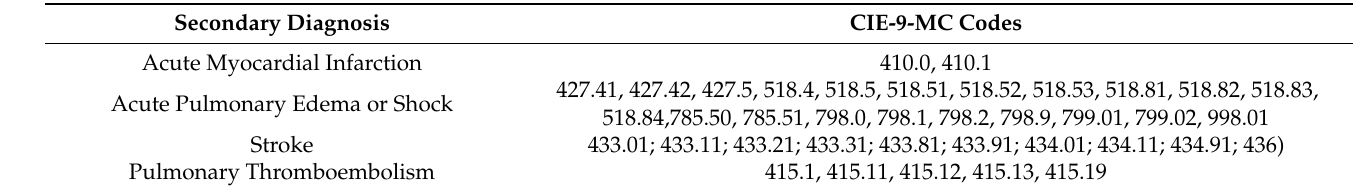
Table 1. Major complications